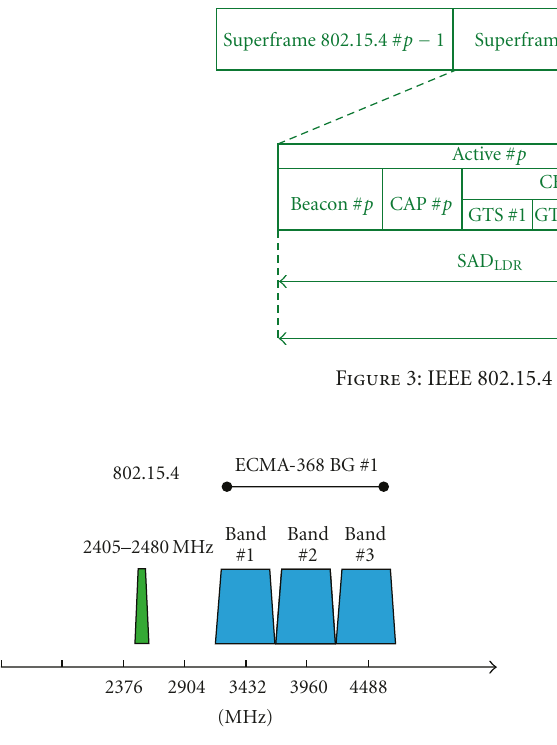
Figure 4: Frequency separation between the considered standards.